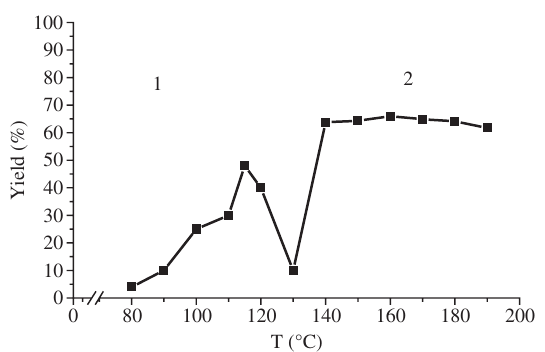
Figure 4: Temperature dependence for the α -naphthol conversion by carboxylation in carbon dioxide medium (P Region 1 (80–130 ° C) refers to the synthesis of 1-hydroxy- 4- naphthoic acid and region 2 (130–190 ° C) is that of the synthesis of 1-hydroxy-2-naphthoic